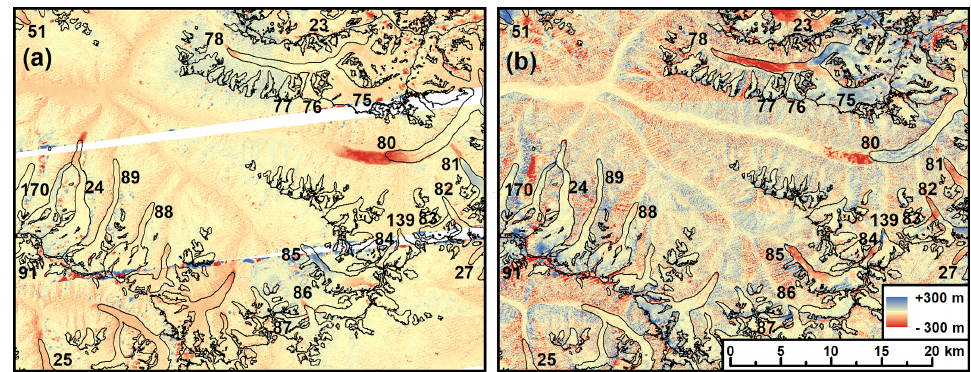
Figure 3. Two examples of colour-coded DEM difference images used to identify surging glaciers (marked with their ObjectID). The glacier outlines depict the glacier state in ∼ 2000 (GI-2). (a) SRTM-Corona (2000–1968) and (b) AW3D30-SRTM ( ∼ 2010–2000).